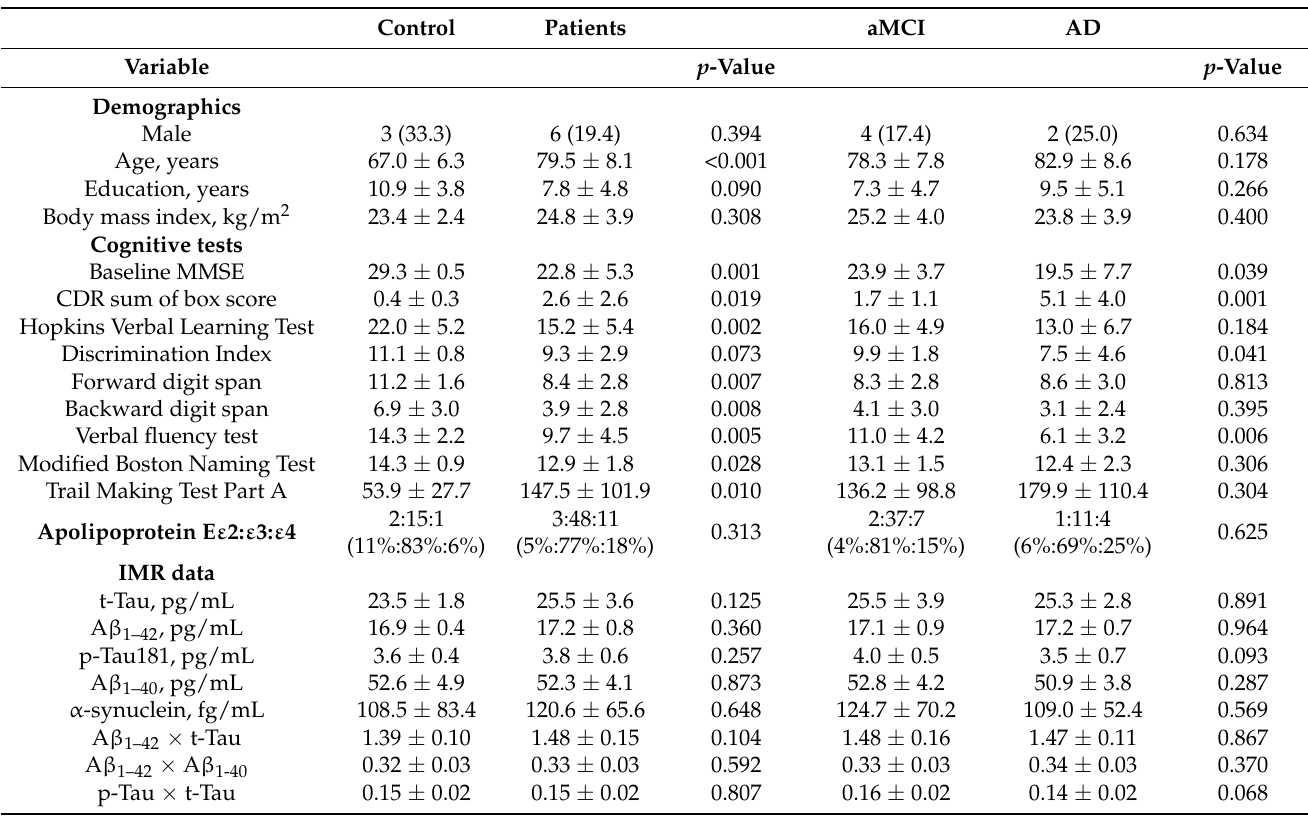
Table 1. Baseline characteristics of the 40 enrolled participants according to disease group.